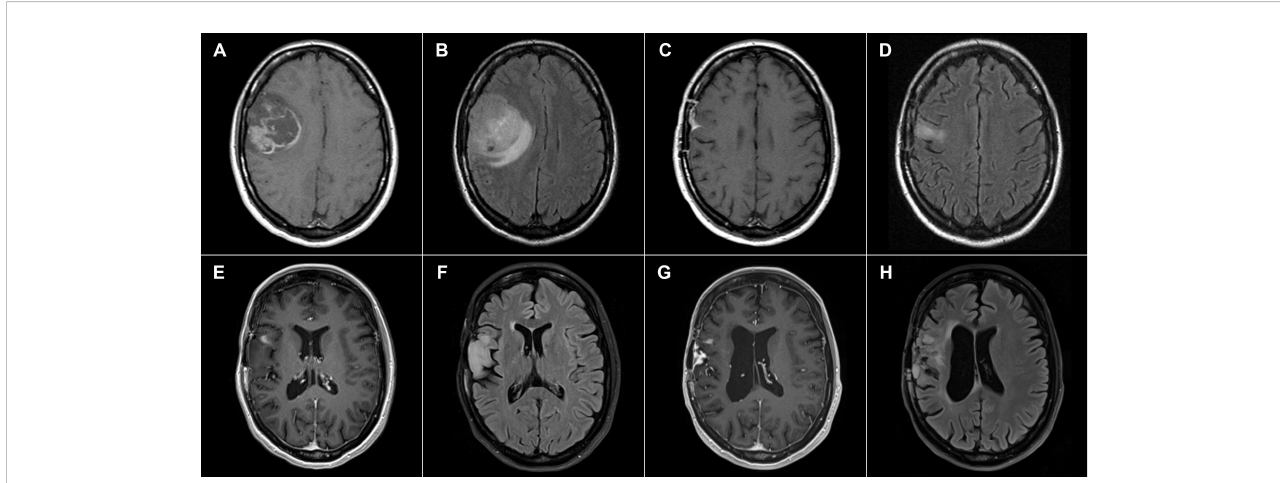
FIGURE 2 33-year-old female. (A) November 2005, 1 Tesla scanner: T1-weighted postcontrast spin echo preoperative image showing a GBM in the right central region. (B) Corresponding FLAIR image. (C) April 2006, 1 Tesla scanner, T1-weighted postcontrast spin echo postoperative image with a residual extra- axial enhancement. No enhancing residual tumor is present. (D) Corresponding FLAIR image. (E) 3 Tesla scanner, January 2021, T1-weighted postcontrast MP-RAGE sequence 181 months after surgery with signs of tumor recurrence in the right opercular region. (F) Corresponding FLAIR image. (G) 3 Tesla scanner, May 2022, T1-weighted postcontrast MP-RAGE sequence with a second recurrence in the same region. (H) Corresponding FLAIR image.